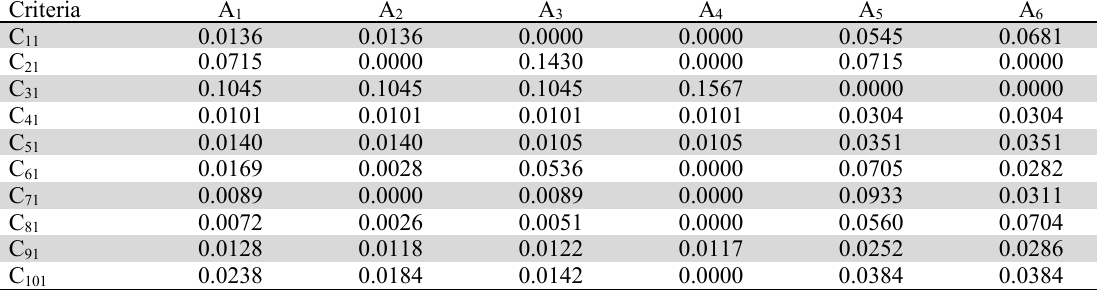
The case study technical criteria weighted normalised decision matrix